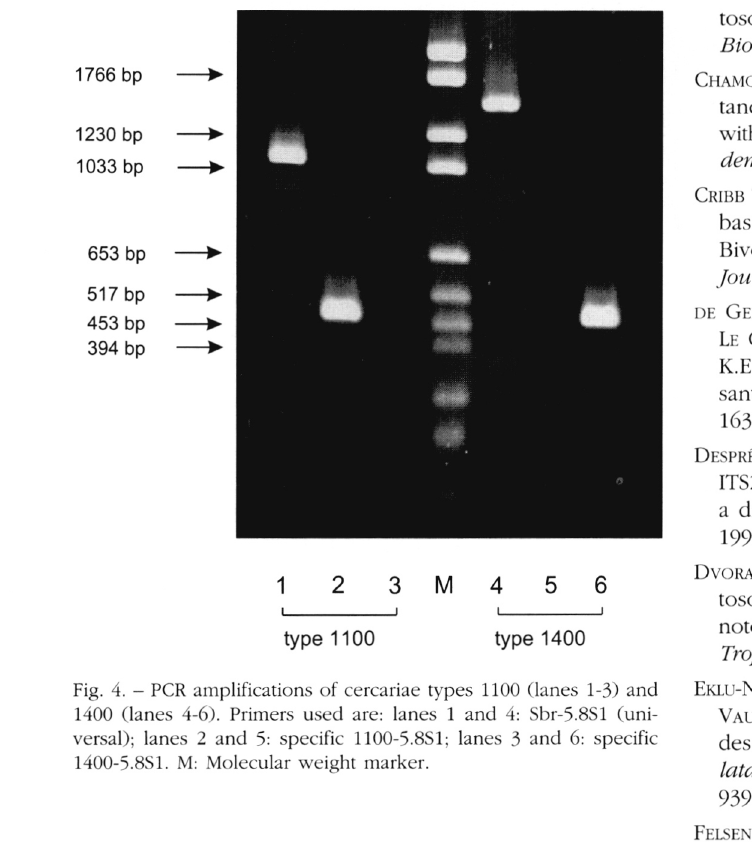
Fig. 4. - PCR amplifications of cercariae types 1100 (lanes 1-3) and 1400 (lanes 4-6). Primers used are: lanes 1 and 4: Sbr-5.8S1 (uni­ versal); lanes 2 and 5: specific 1100-5.8S1; lanes 3 and 6: specific 1400-5.8S1. M: Molecular weight